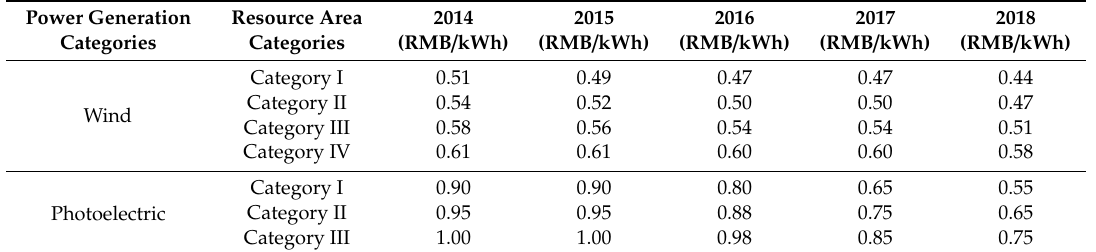
Table 2. The feed-in tari ff of wind power and photovoltaic, data sourced from